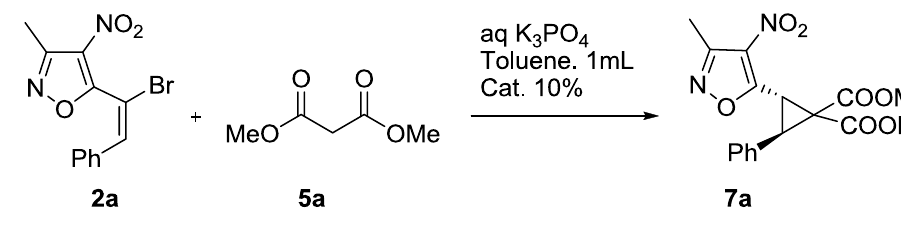
Table 1. Representative results from the screening of Cinchona derived